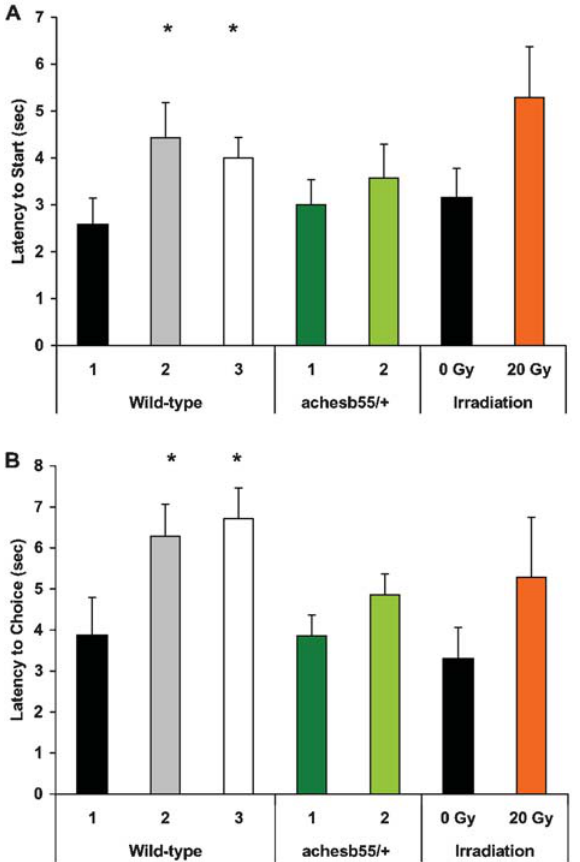
Figure 9. Latency to Start (A) and Choice (B) at Baseline T-maze test in different groups of zebrafish. X-axis – fish age (years) and treatment. * p , 0.01, relative to young control of the same strain or treatment group.